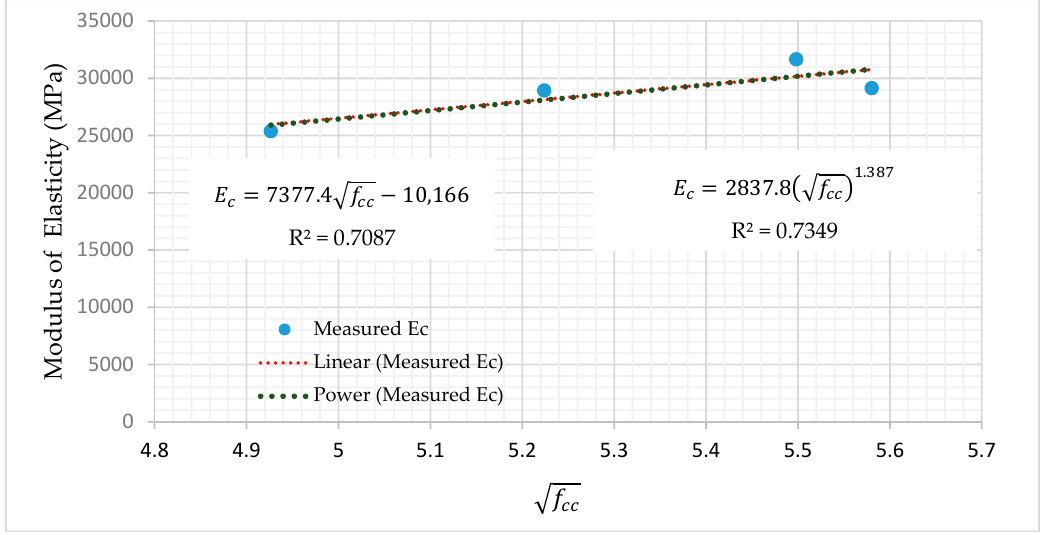
Figure 10. The relationships between E c and f cc in the form of IS456-1989 equations.